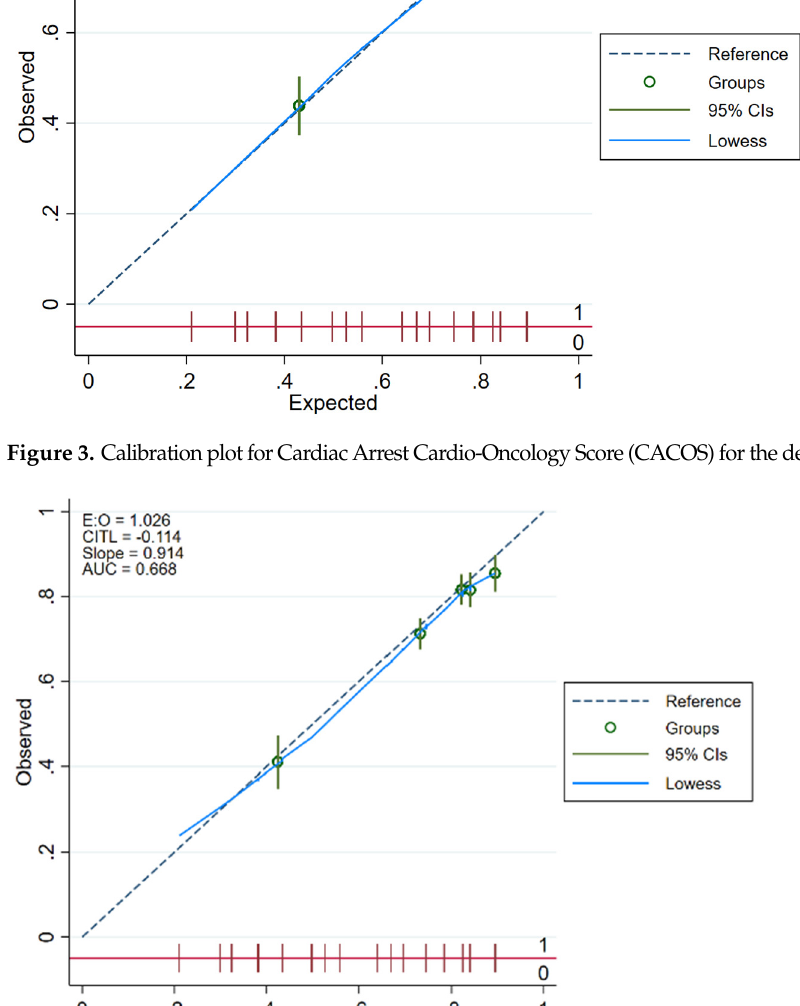
Figure 4. Calibration plot for Cardiac Arrest Cardio-Oncology Score (CACOS) for the verification